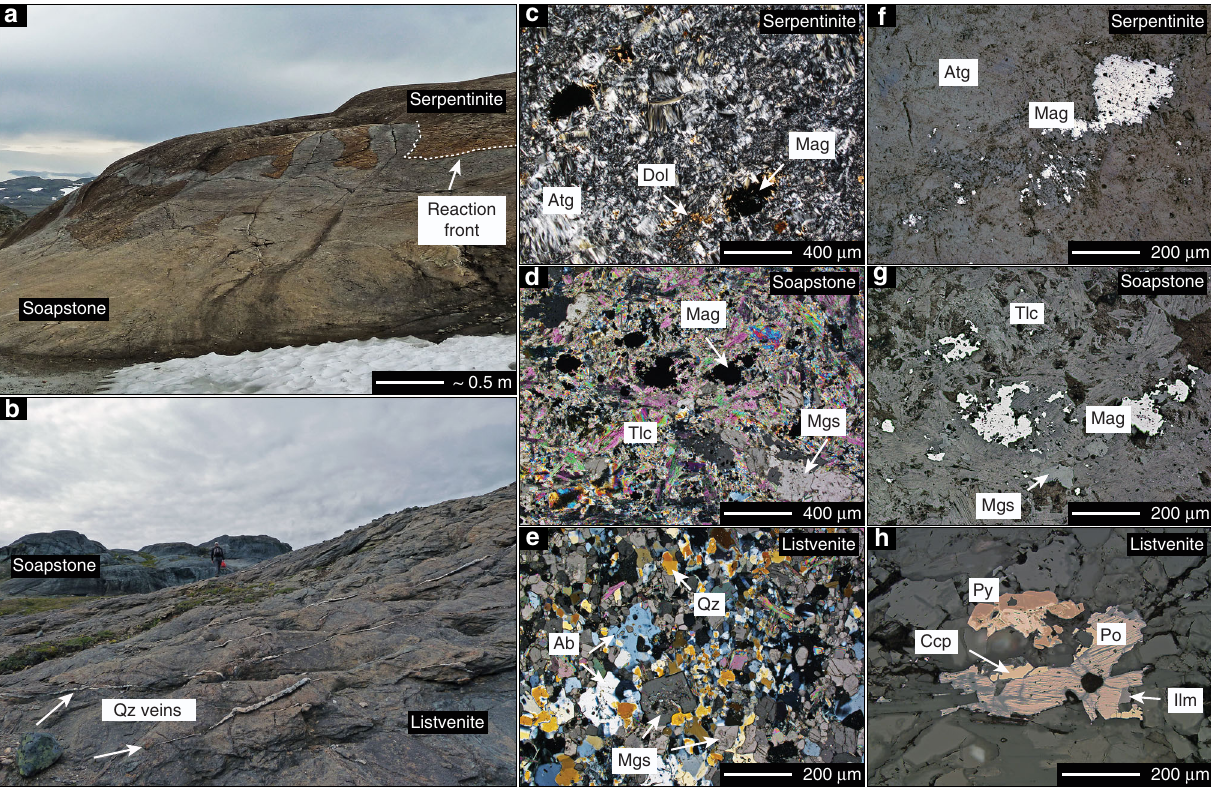
Fig. 2 Field and microtextural relationships of carbonated serpentinite. a Field image of a sharp soapstone reaction front locally following fractures in the serpentinite. b Typical appearance of listvenite in the fi eld with abundant quartz veinlets in front of massive soapstone (person for scale). c – e Representative micrographs of serpentinite, soapstone, and listvenite mineral assemblages in cross-polarized transmitted light. f – h Re fl ected light micrographs of oxide and sul fi de phases in serpentinite, soapstone, and listvenite. Magnetite in serpentinite and soapstone is present as large grains and as fi ne grained matrix constituent with grain-sizes between ~10 µ m and ~500 µ m. Listvenite contains in most cases only relict amounts of magnetite and sometime additional pyrite and chalcopyrite together with minor pyrrhotite. Mineral abbreviations follow Whitney and Evans